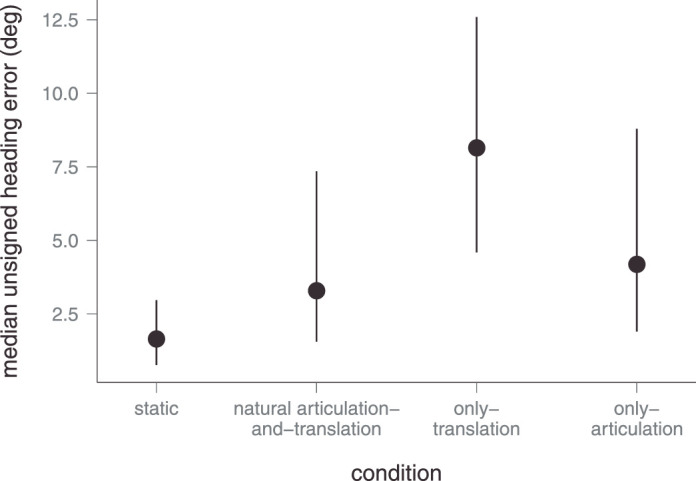
Median unsigned heading errors across all subjects and facing directions for each experimental condition. Error bars give the upper and lower interquartile ranges.